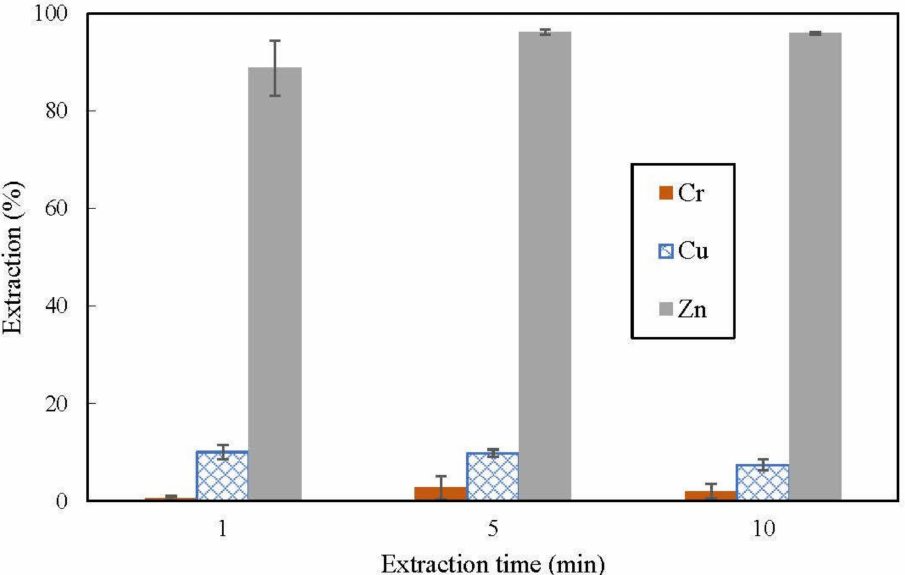
Figure 2. Effect of shaking time on extraction of metal ions from pH 3 feed containing 100 ppm chromium (VI), copper and zinc; organic phase consisted of 3% ( v / v ) D2EHPA in